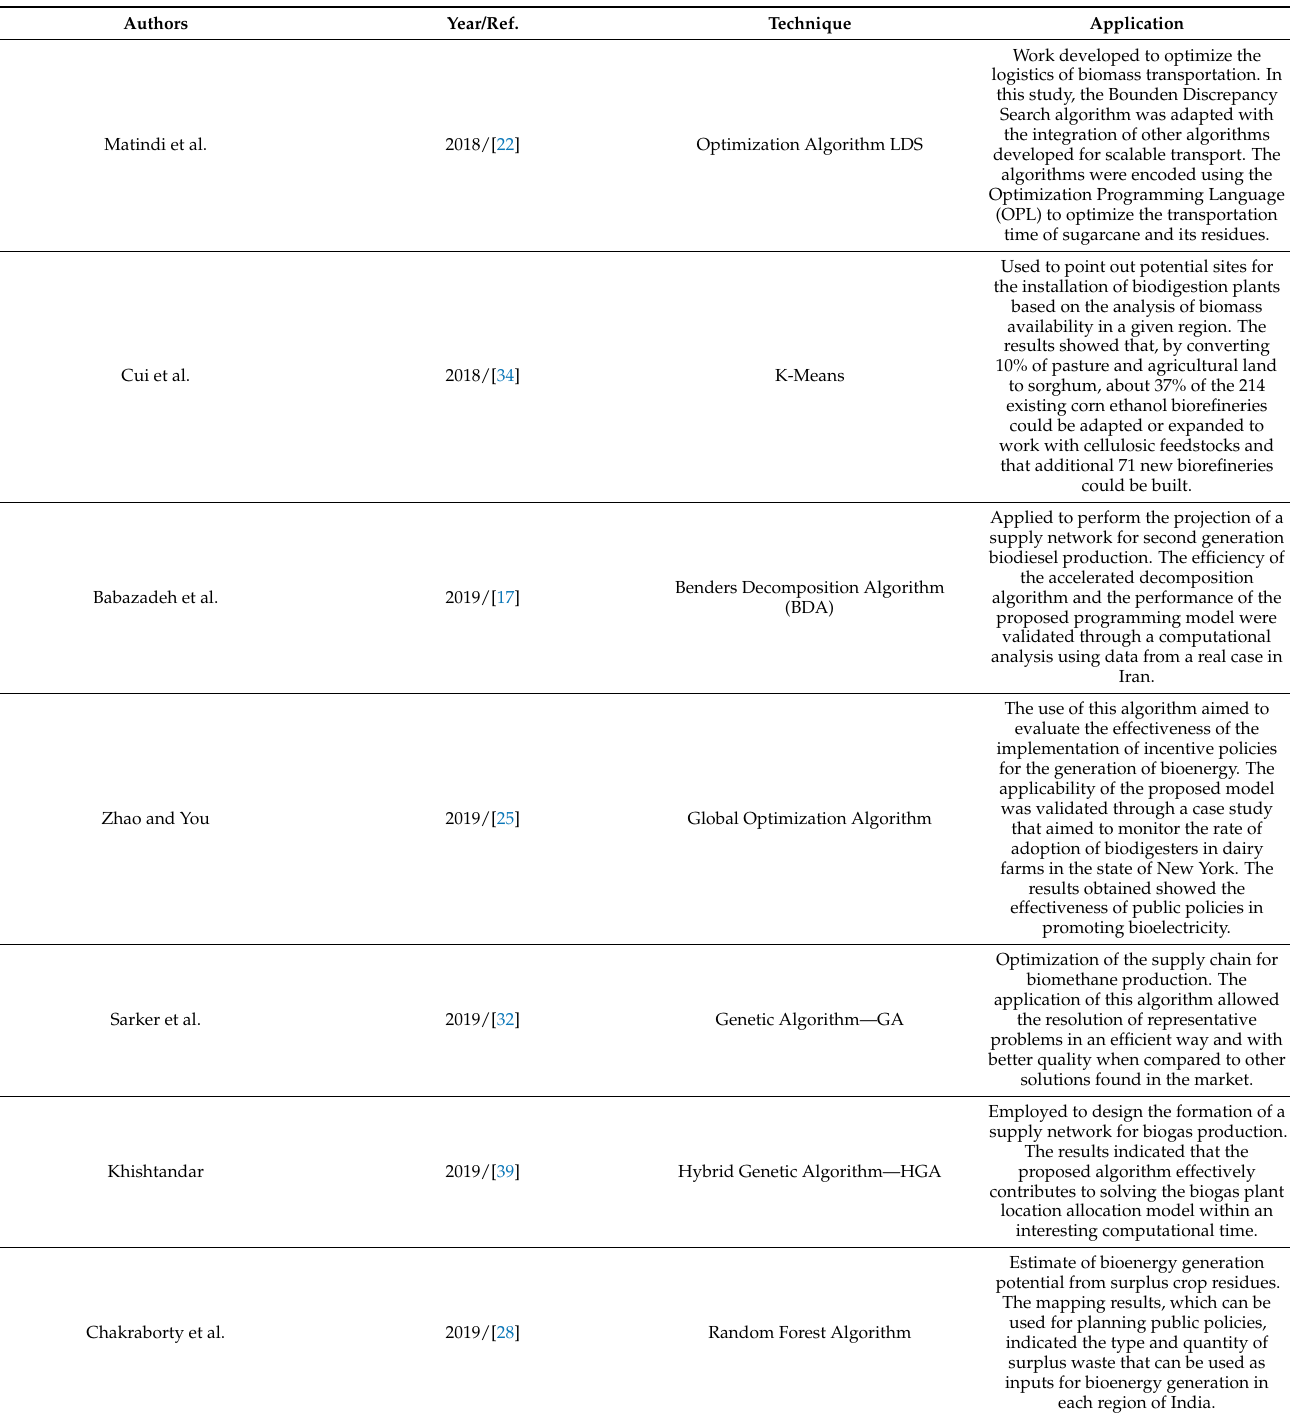
Table A3. Algorithm models identified in the analysis portfolio as well as their applications and expected results from 2018 and